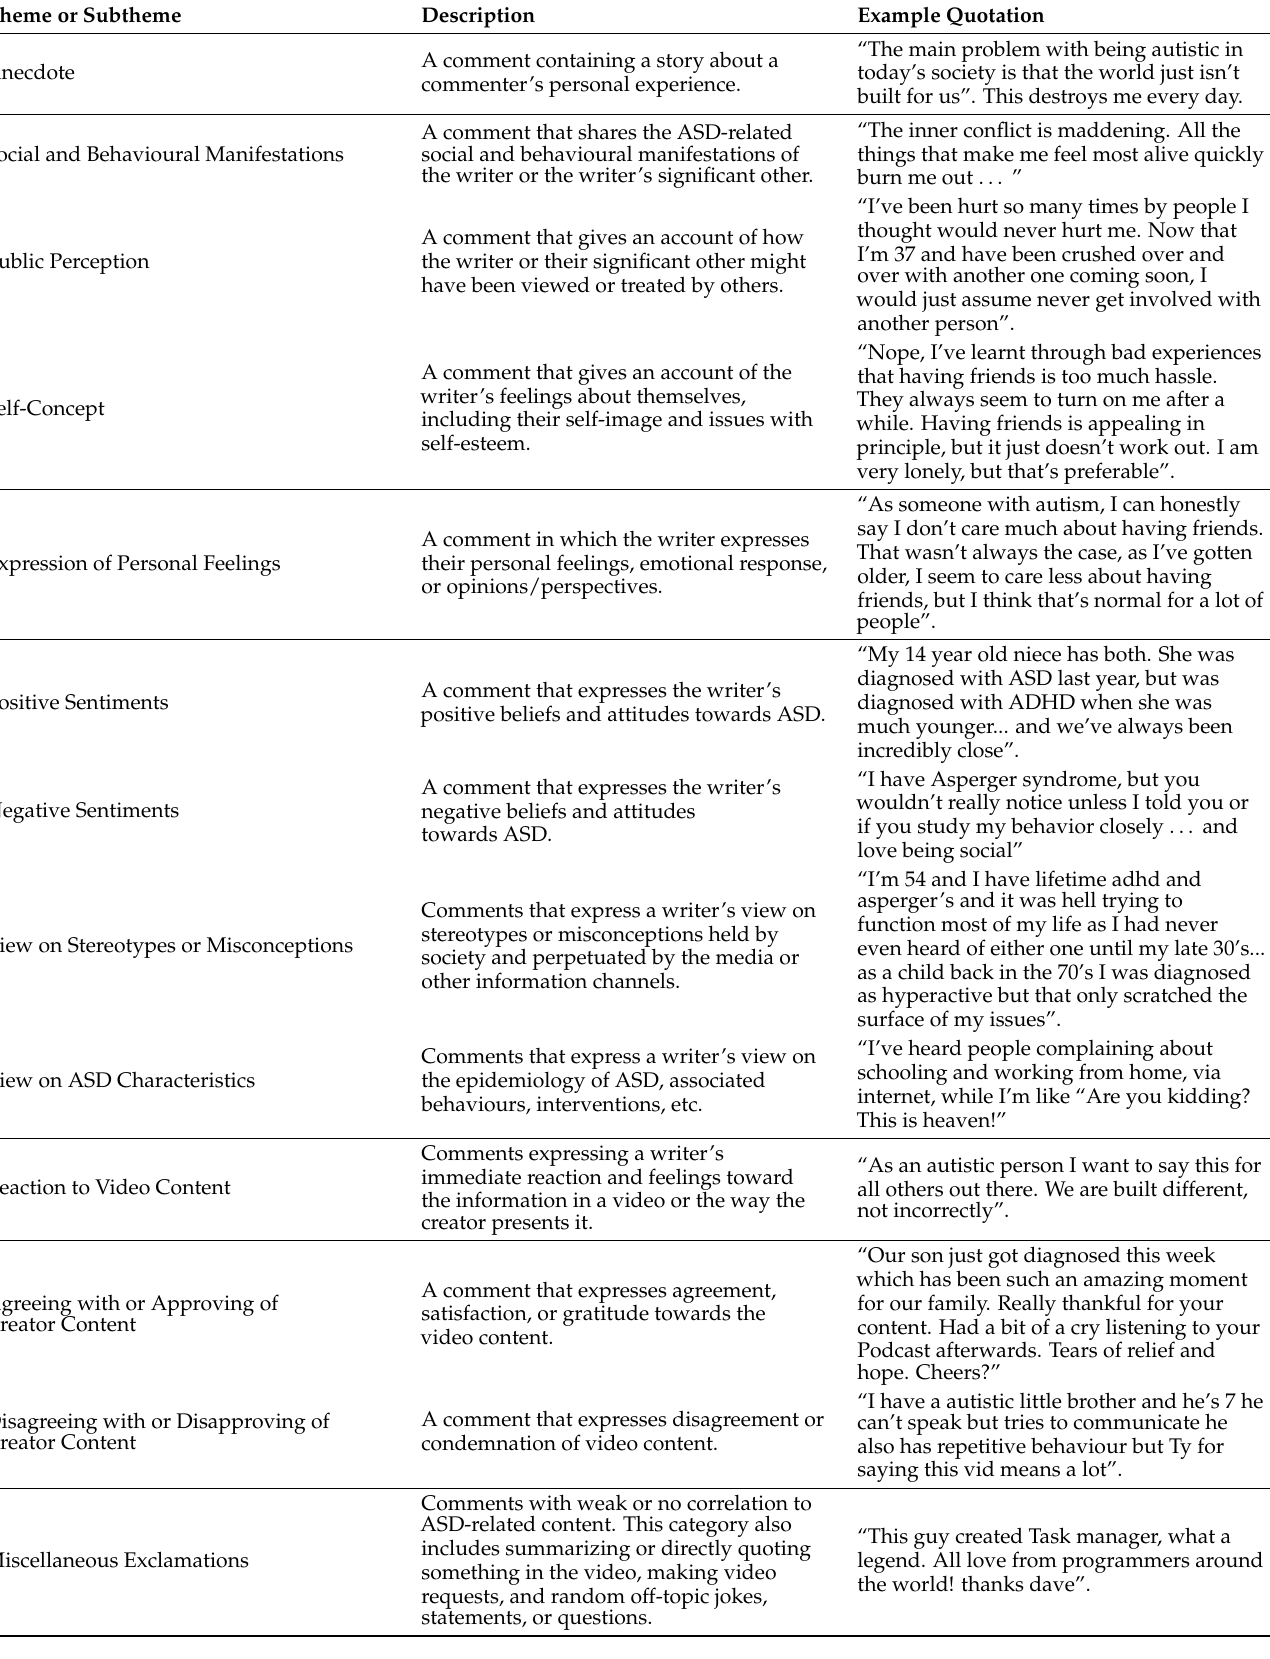
Table 4. Themes and subthemes in YouTube comments with example quotes